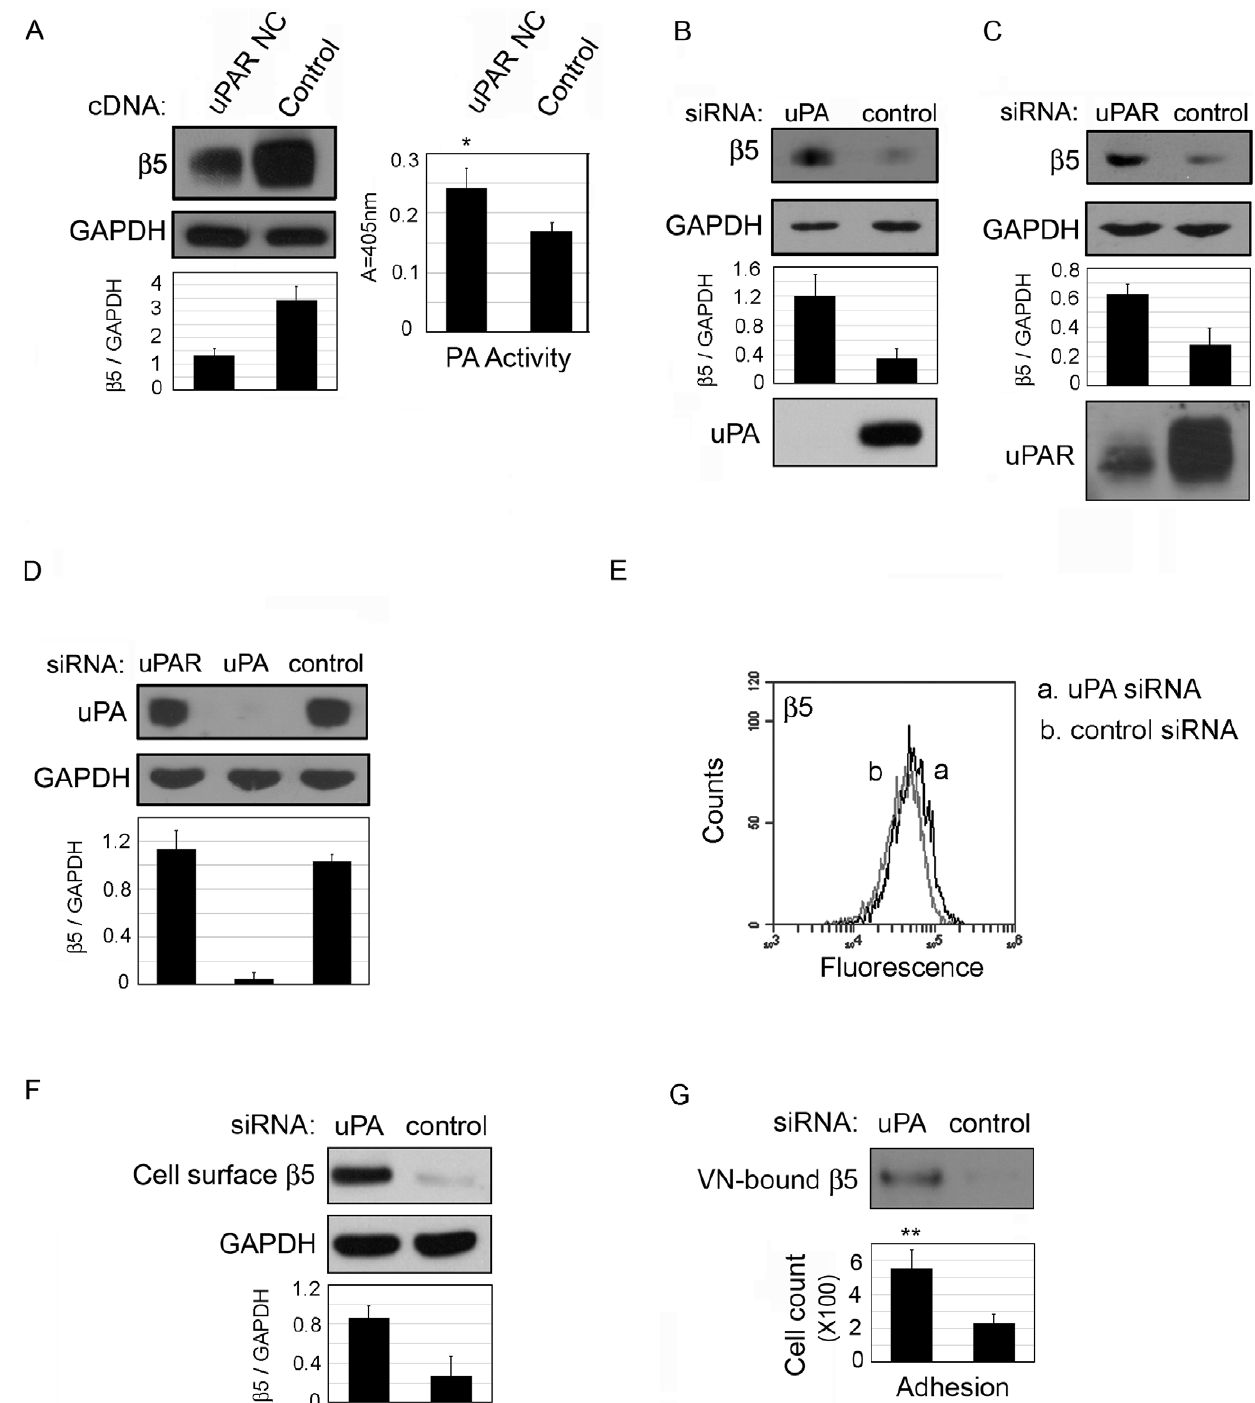
Figure 2. uPA expression controls integrin b 5 levels. (A) HCFs were transfected with a non-cleavable uPAR mutant cDNA (uPAR NC) or control vector. After 48 hours, cells were lysed and subjected to Western blot analysis for integrin b 5. GAPDH indicates equal loading. Cell associated PA activity was measured colorimetrically by adding plasminogen and a chromogenic substrate for plasmin to cell lysates. Cell associated PA activity is shown to the right. *p value , 0.05. HCF were transfected with (B) uPA siRNA or non-targeting siRNA control or (C) uPAR siRNA or non-targeting siRNA control. After 24 hours, lysates were Western blotted for b 5 and uPA or uPAR to confirm knockdown. (D) HCF were transfected with uPAR siRNA, uPA siRNA, or control siRNA. After 24 hours, lysates were Western blotted for uPA. The data in (D) demonstrate that uPA is still expressed after uPAR silencing with uPAR siRNA. GAPDH indicates equal loading. (E–G) HCFs were transfected with uPA siRNA or control siRNA. (E) Flow cytometry. (F) Cell- surface biotinylation: After 24 hours, HCFs were cell-surface biotinylated before lysing and IP with streptavidin-HRP beads followed by Western for b 5. GAPDH indicates equal input of protein for IP. (G) Integrin b 5 bound to vitronectin (VN), top: After 24 hours, HCFs were treated with a cleavable cross- linker and cells were removed by lysis with 0.1% SDS. Next, the cross-linker was cleaved, releasing VN-bound proteins. This fraction was concentrated equal protein was Western blotted for b 5. Bottom: Cell adhesion on VN: 24 hours after transfection, cells were detached and plated on VN for another 24 hours. Cells were fixed, stained with DAPI and counted. **p value , 0.01. N=3–7 for each experiment.